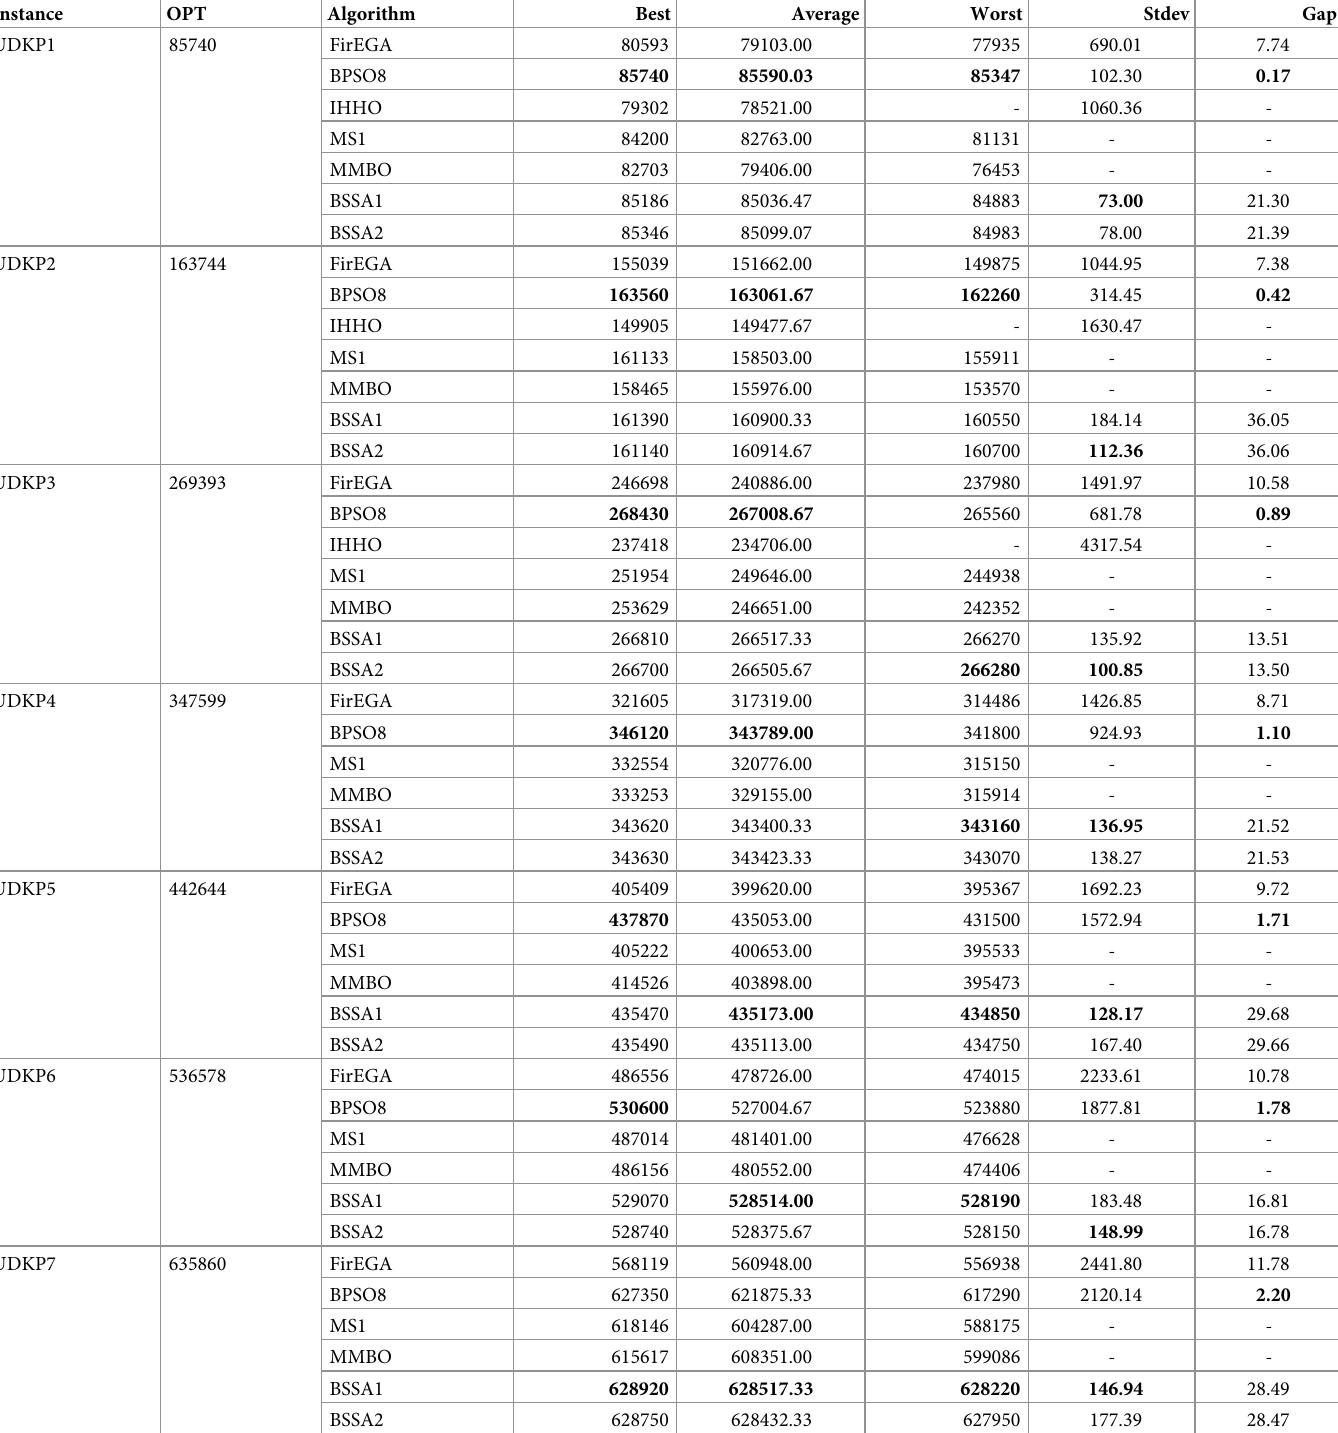
Table 7. Test results with uncorrelated